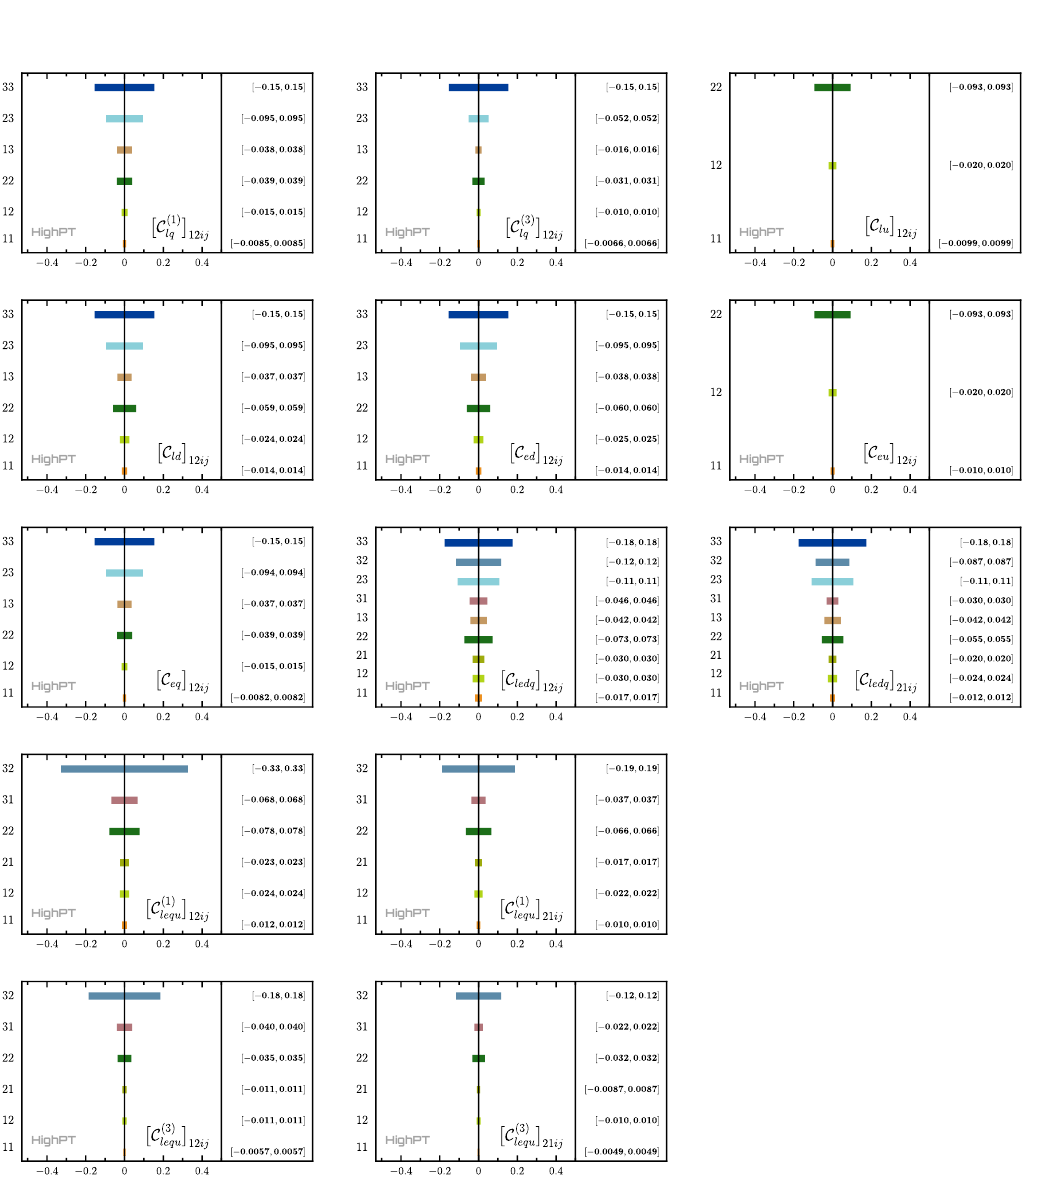
Figure 19. LHC constraints on semileptonic d = 6 Wilson coefficients with eµ flavor indices, where a single coefficient is turned on at a time. See caption of figure